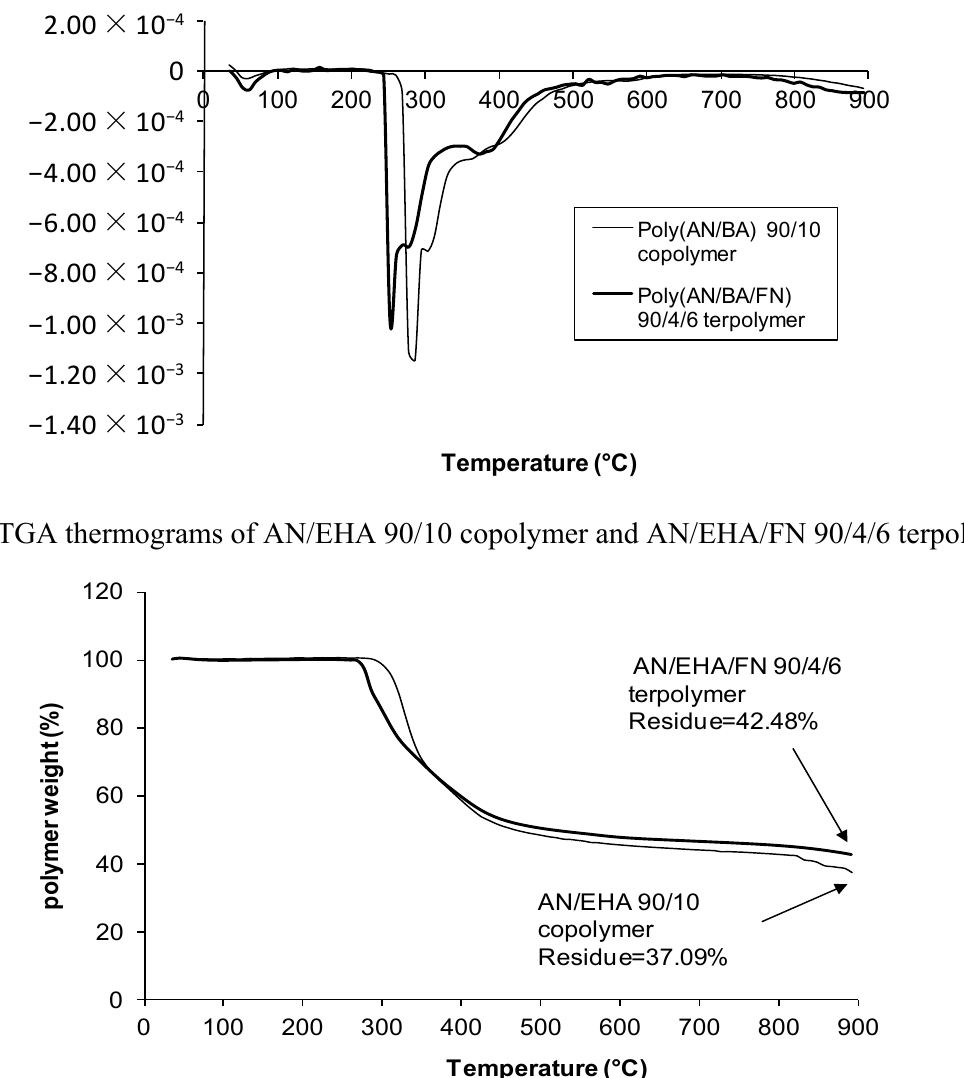
Figure 7. DTG curves of AN/BA 90/10 copolymer and AN/BA/FN 90/4/6 terpolymer.